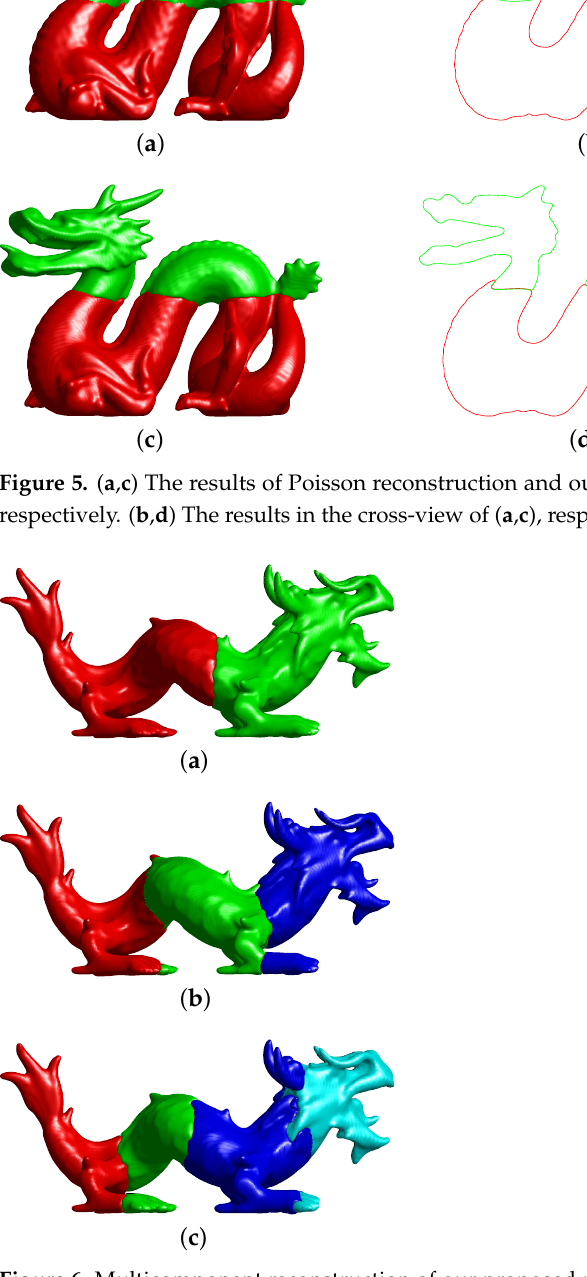
Figure 6. Multicomponent reconstruction of our proposed method. ( a ) Two-component reconstruc- tion. ( b ) Three-component reconstruction. ( c ) Four-component